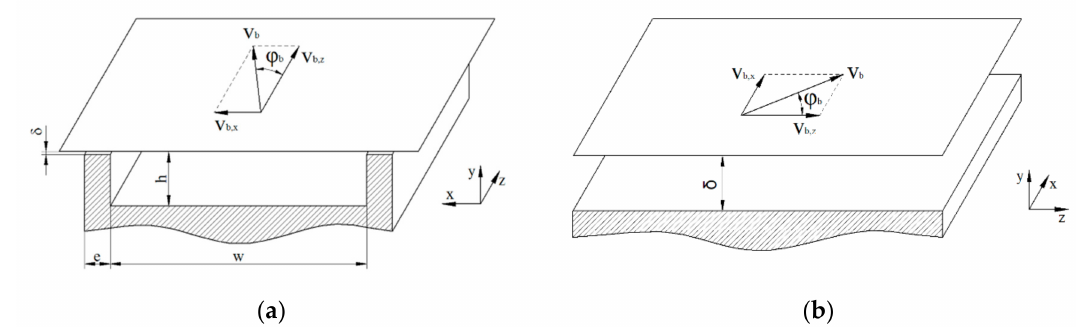
Figure 4. Flat-plate approximation of the unwound screw channel ( a ) and the flight clearance ( b ). In the representation of the flight clearance, the flow channel was rotated clockwise by 90 ◦ : x is the direction across and z the direction along the